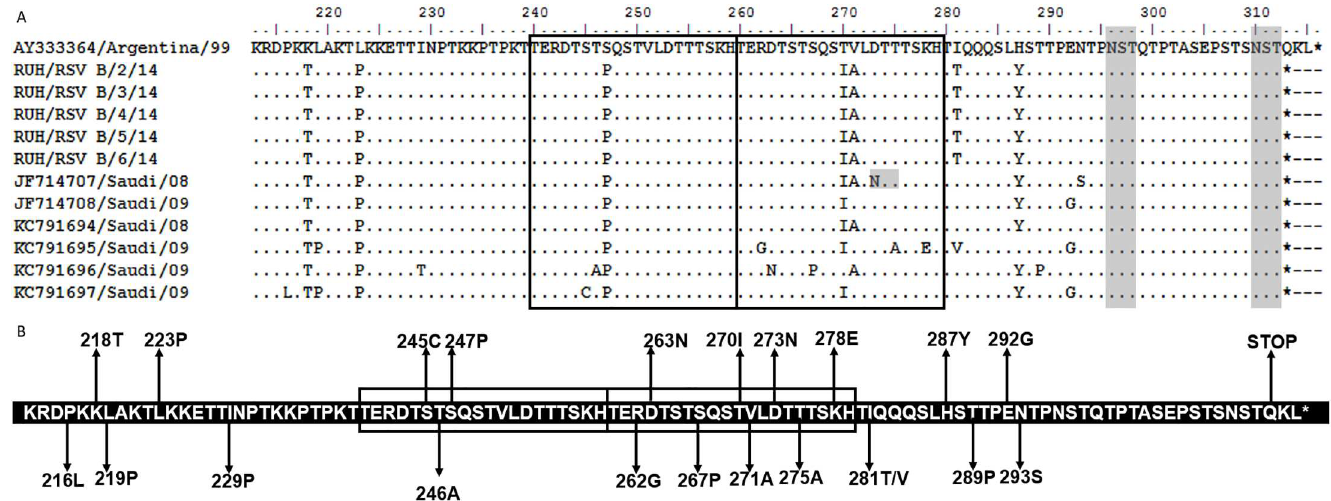
Fig 4. (A) Deduced amino acid alignment and mutations in the second variable region of G protein of the BA genotype. The figure includes alignment of Saudi BA strains with the prototype BA strain from Argentina(AY333364). The amino acids sequencealignment correspondsto 213–315 amino acids of the prototypestrain. Identicalresidues are indicatedby dashes. The two copies of the duplicated 20-amino-acid region in group BA strains are indicatedby rectangular boxes. Stop codons are indicatedby asterisks. Potential N-glycosylation sites (NXT, where X is not proline)are indicatedby grey shading. (B) The amino acid sequence of the BA genotype showing mutations in the Saudi strains. The sequencecorresponds to the 227–297 amino acids of the BA prototype strain. The rectangular boxes represent the analogous20 amino acid regionfollowedby duplicated 20 amino acid region in BA RSV strains. Changesat amino acid positions in Saudi strains are shown by arrows.